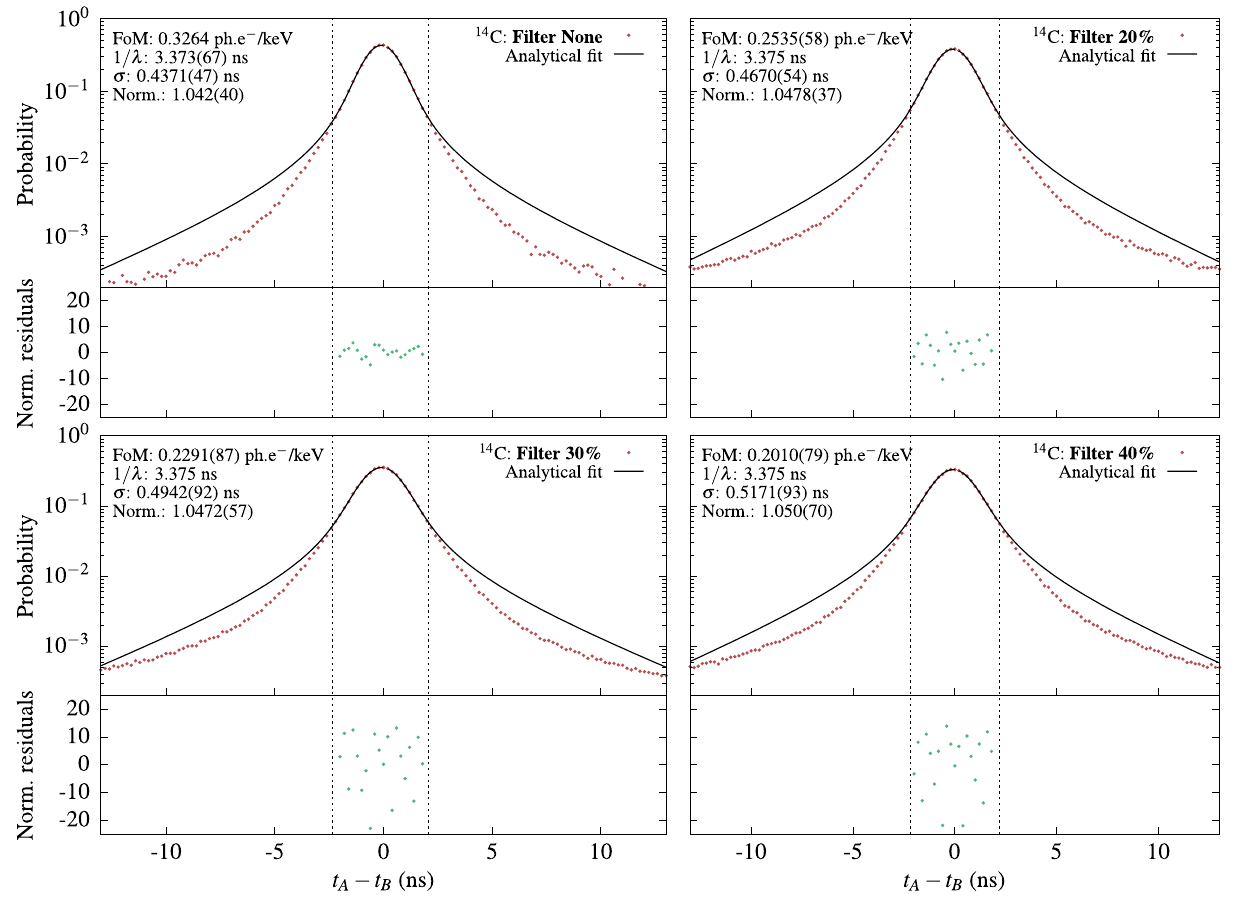
14 Figure 10. Cross-correlation spectra of a C LS-source in toluene+PPO cocktail. All experimental spectra are fitted with Eq. (29) with a fixed (cid:31) and normalization parameters.